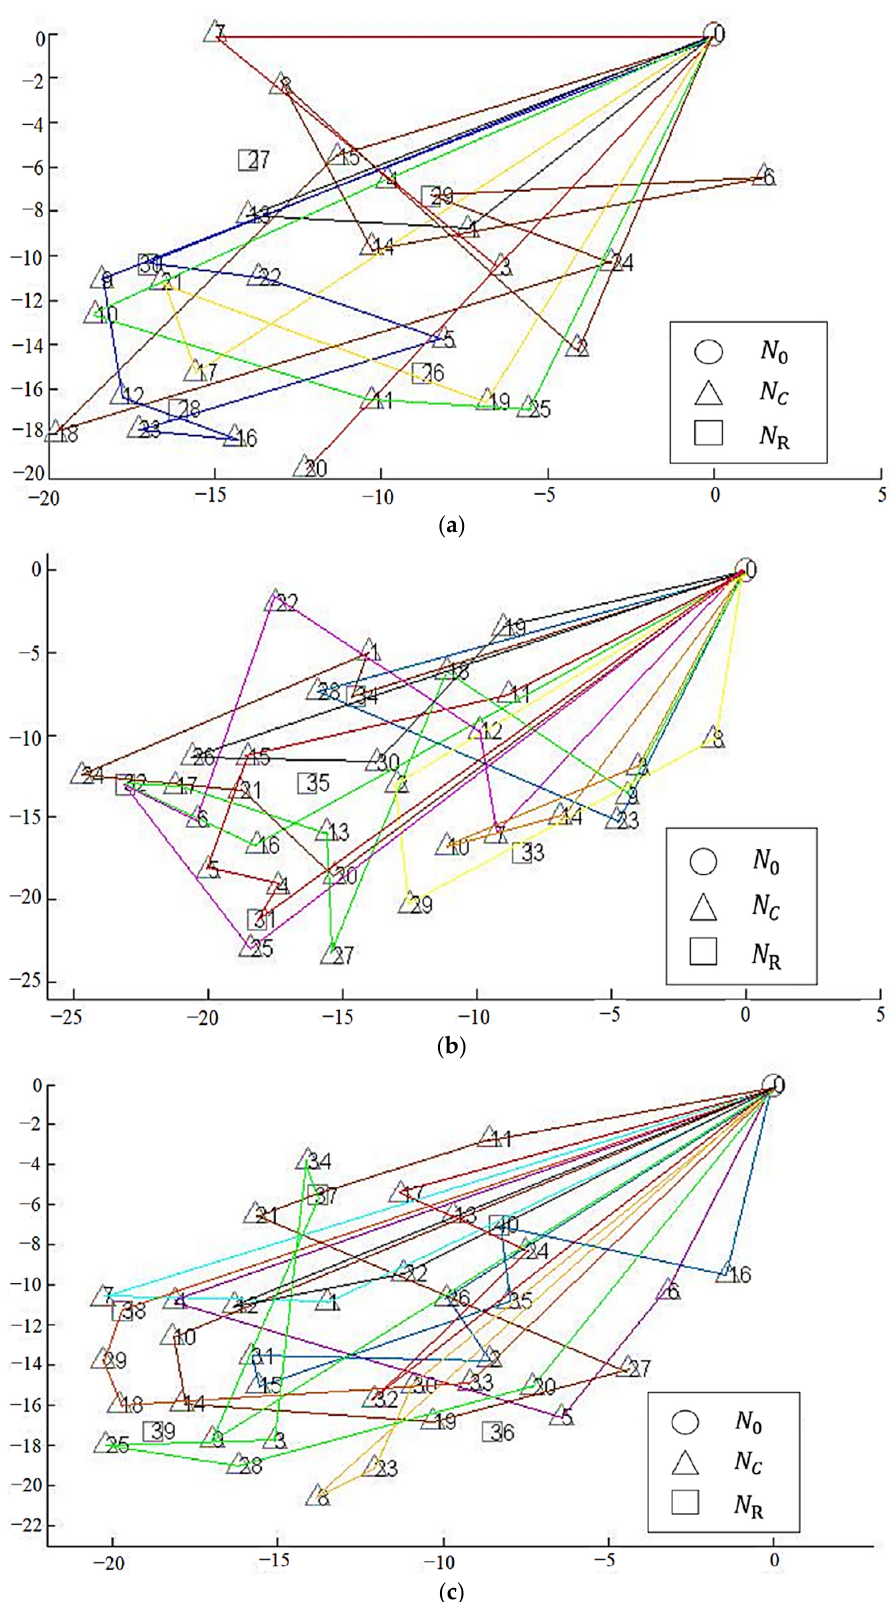
Figure 10. Mapping of optimal delivery paths for L-EVRPTW: ( a ) Scenario 1; ( b ) Scenario 2; ( c ) Scenario